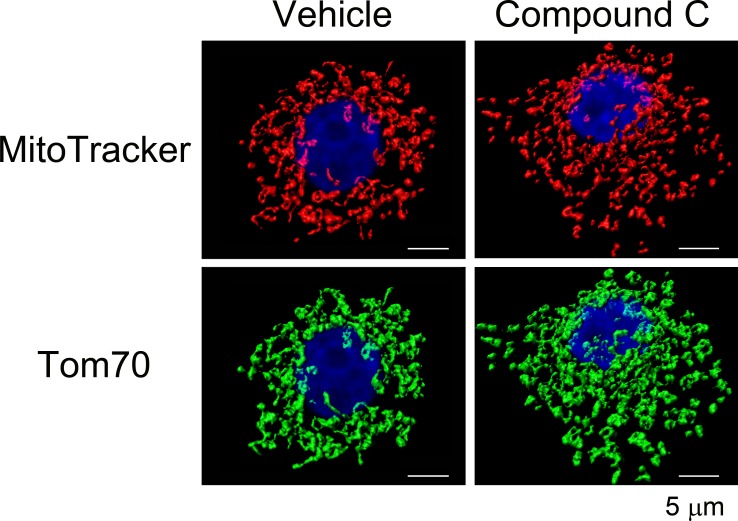
Impact of compound C on mitochondrial morphology.LLC-PK1 cells were treated with the vehicle DMSO or compound C and processed as described for Fig. 2. Mitochondrial morphology was visualized by 3D reconstruction for confocal stacks. Note that mitochondrial fragmentation with compound C was obvious for compartment demarcation with MitoTracker or Tom70. Scale bars for all panels are 5 µm.